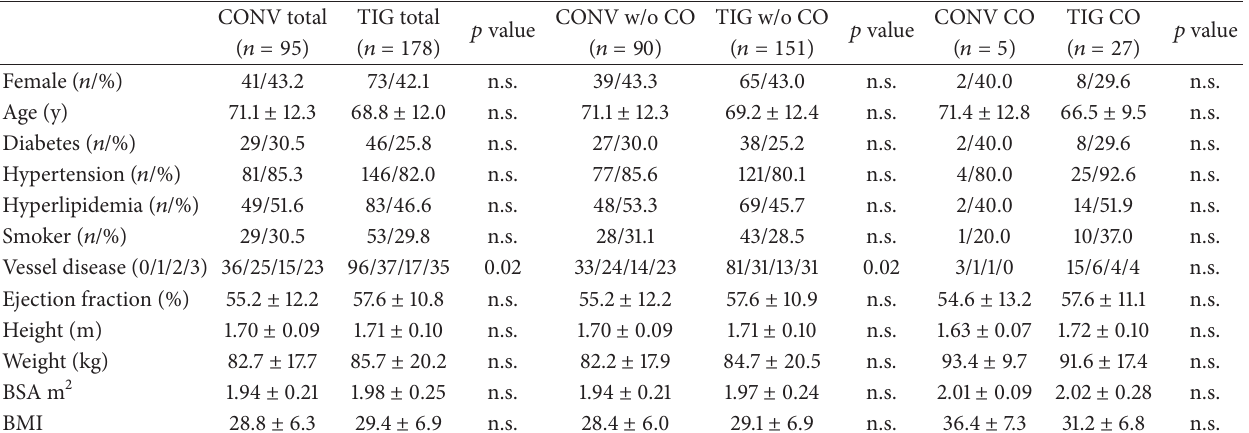
Table 1: Baseline characteristics.